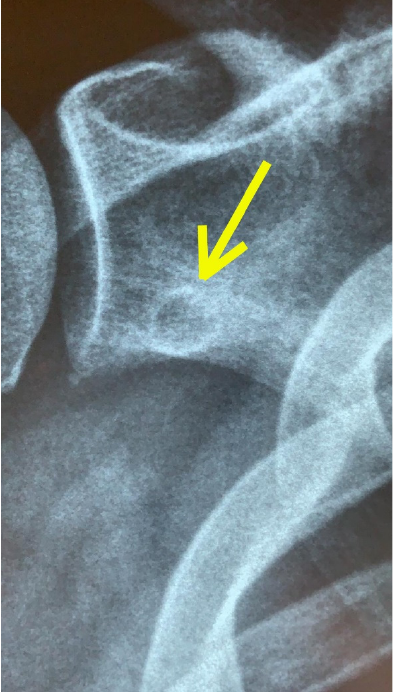
Figure 3. X-ray imaging. A small radiolucent formation is present on the lower portion of the scapular neck with hyperdense margins and an intact cortical rim of non-univocal interpretation (yellow arrow).